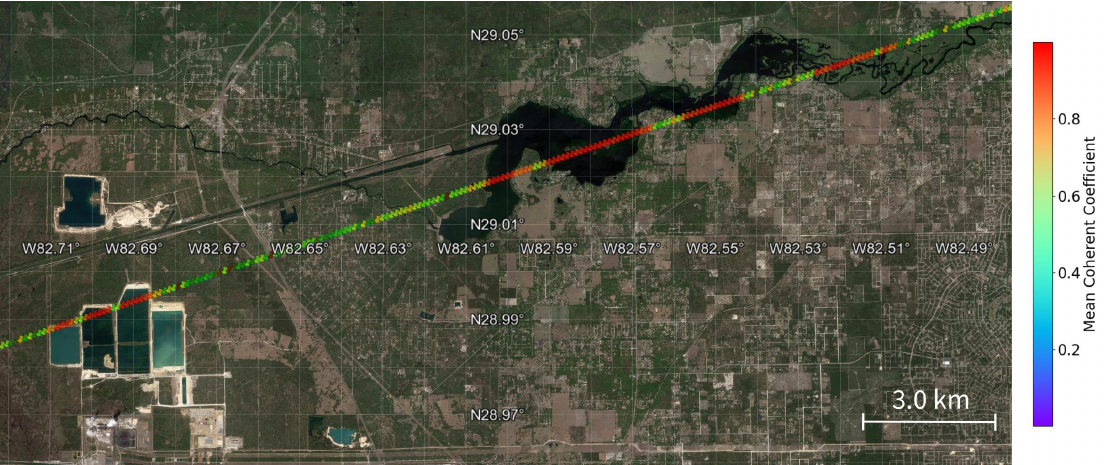
Figure 7. A demonstration of surface characterization using the coherence of the reflected signal. The raw IF data was collected by CYGNSS FM02 on 13 September 2018 over Florida, US. The GNSS transmitter is Galileo PRN 31. Each pixel along the track corresponds to a ground distance of ∼ 120 m. The background image is extract from Google